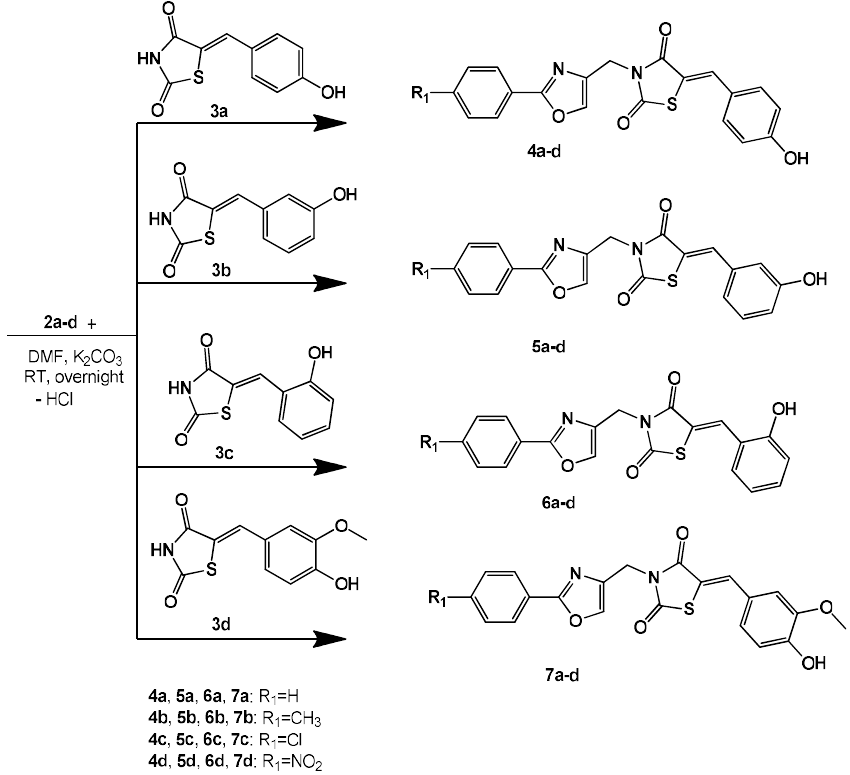
Figure 3. The synthesis of the N -(oxazolylmethyl)-thiazolidinedione ( 4 , 5 , 6 , 7 : a – d ).